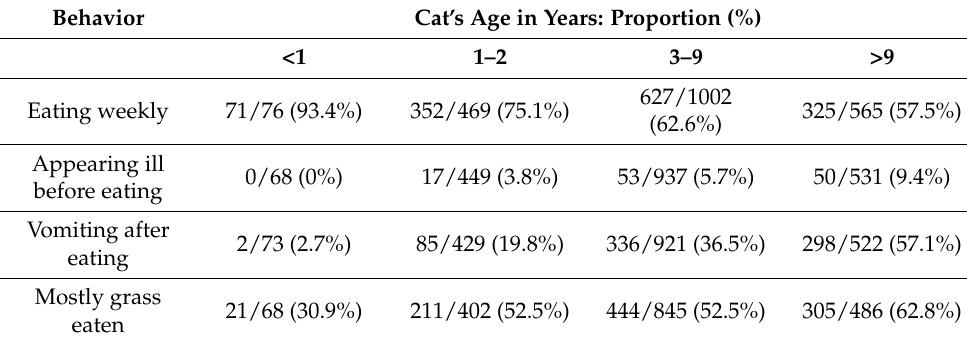
Table 1. Behaviors associated with plant eating. The analyses compared cats in various age groups for an increase or decrease in trends in the frequency of the behavior in question according to the Mann–Kendall test based on the Kendall’s tau. The numbers in the pool vary depending on the respondent’s ability to observe the